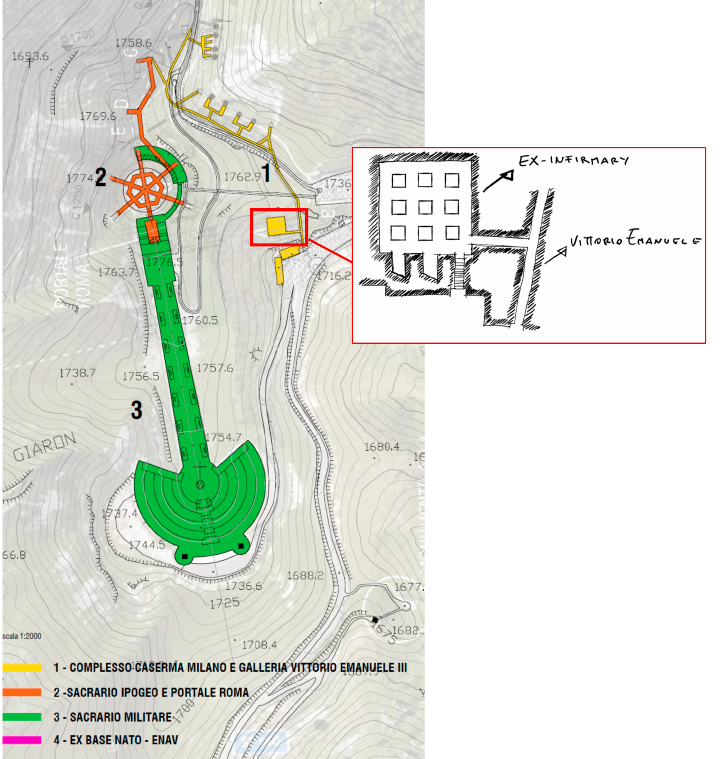
Figure 1. Map of the Cima Grappa Military Shrine. Ex-infirmary and underground tunnels network.